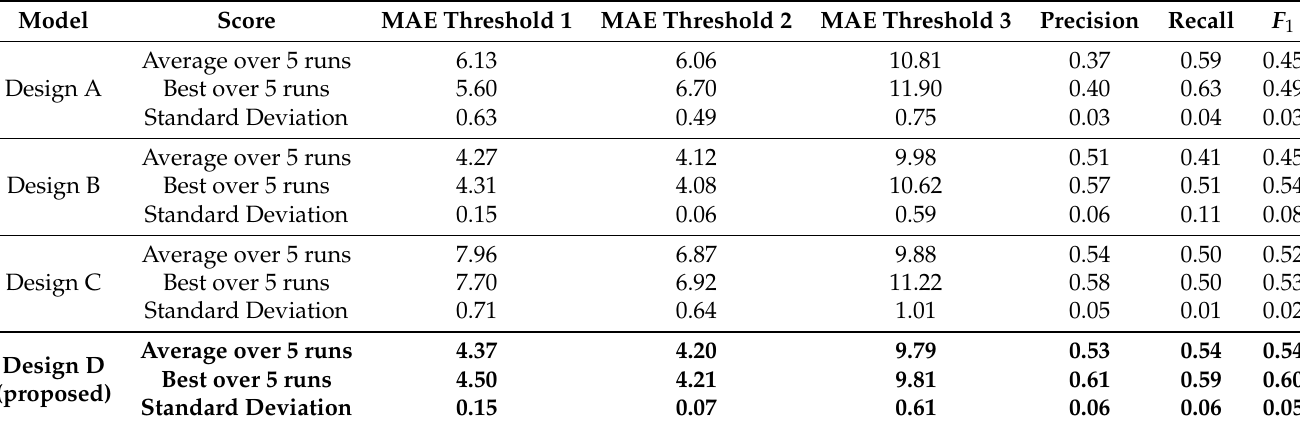
Table 5. Best and average test results out of five runs for anomaly detection using optimised hyperparameters in Table 3 for each NN Design, where MAE is Mean Absolute Error, F 1 is F 1 Score (Equation